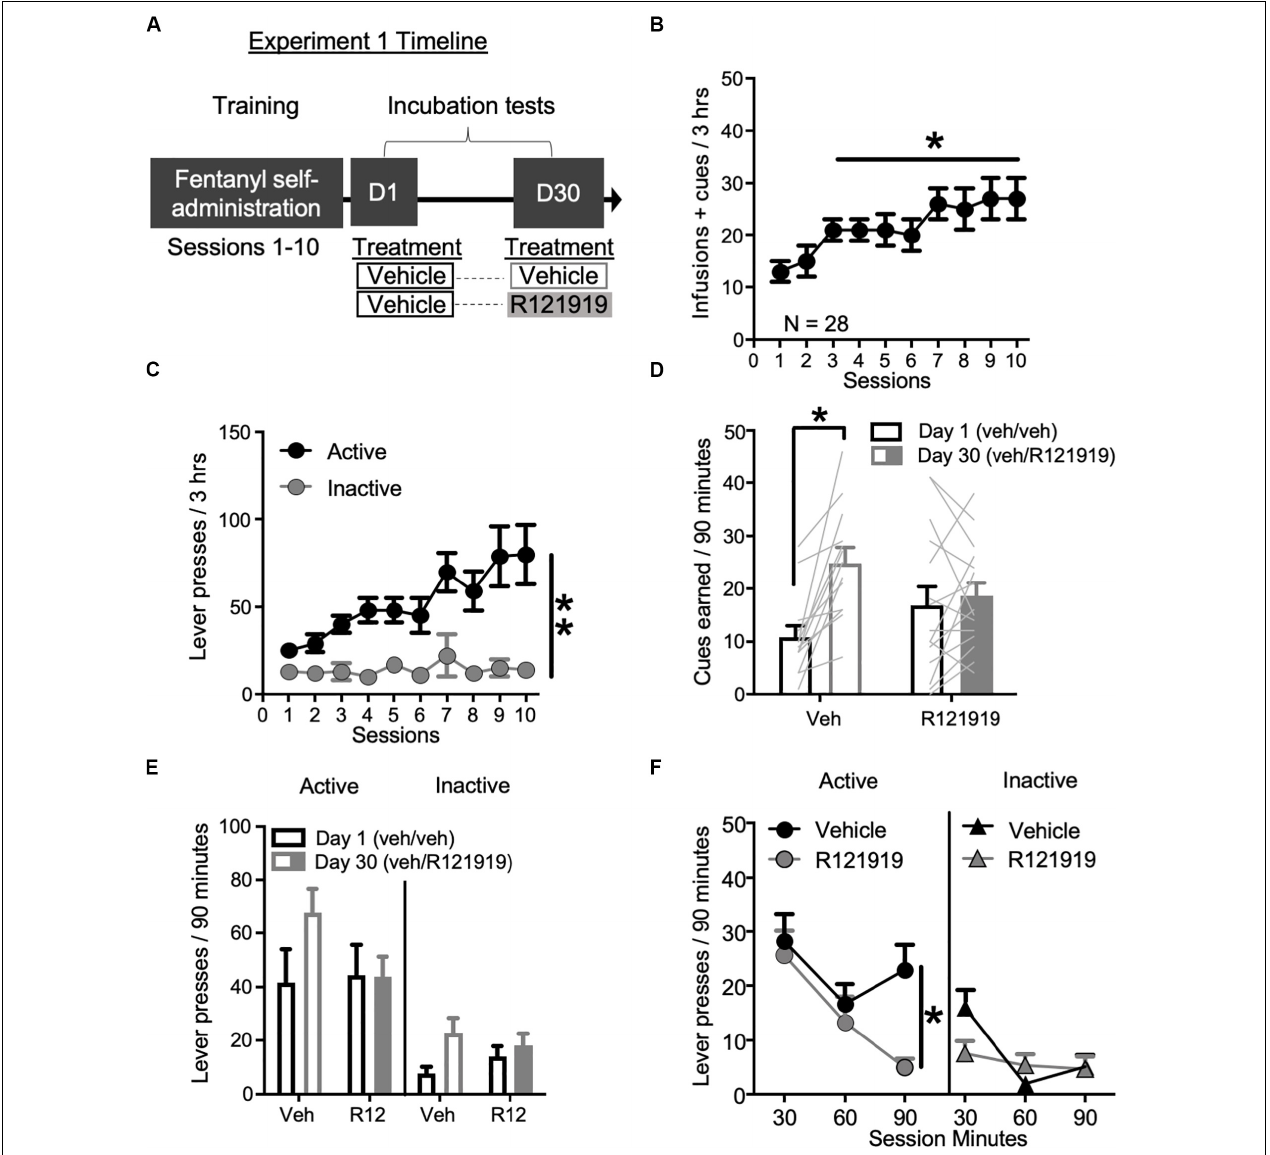
FIGURE 1 | Experiment 1: BNST CRFR1 antagonist effect on incubation of fentanyl craving. (A) Experimental timeline: we trained rats to self-administer fentanyl for 3 h/day for 10 days. On forced abstinence Day 1 and Day 30, we measured lever responding under extinction conditions. (B) Fentanyl infusions + cues earned across the 10 daily self-administration sessions. (C) Rats discriminated Active from Inactive Lever during self-administration training. (D,E) Incubation test data showing cues earned on FR1, 20 s TO schedule (D) and Active/Inactive Lever pressing (E) on Day 1 and Day 30 of forced abstinence for vehicle (open bars) treated and R121919 treated (filled bars) conditions. (F) Time course of Active and Inactive Lever presses on Day 30 test for both treatment groups. * p < 0.05, ** p < 0.01, different from Session 1 in (B) , Lever main effect in (C) , different from Day 1 in (D) , and Treatment main effect in (F) . R12 = R121919. n = 13 Veh, n = 15 R12. Data are mean ±